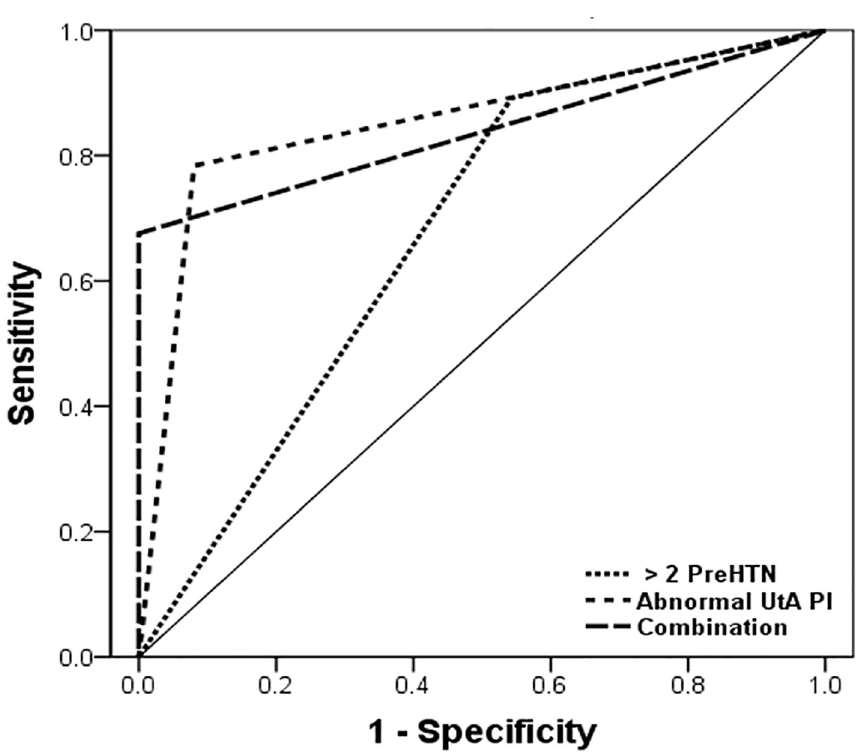
Fig 2. The receiver operating characteristic (ROC) curve of preHTN history and abnormal UtA Doppler for HDP predictions in preHTN group. This curve had the following area under the curve (AUC) values: 0.67 for a history of preHTN, 95% confidence interval (CI) 0.59–0.75; 0.80 for abnormal UtA Doppler, 95% CI 0.77–0.93; and 0.85 for Combination, 95% CI